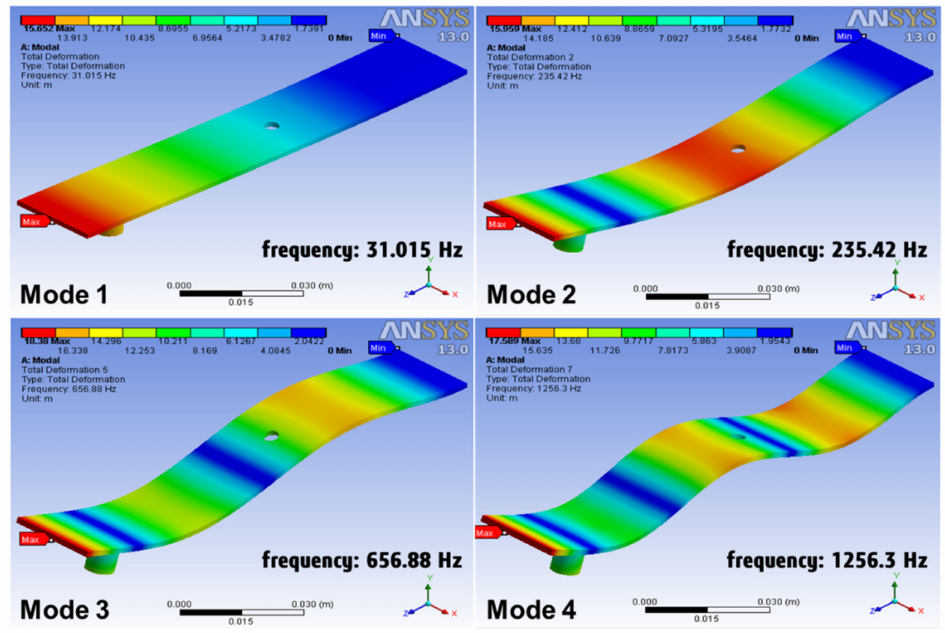
Figure 6. Mode shapes for a single specimen (W = 24 mm, D = 4 mm) in Group 1.